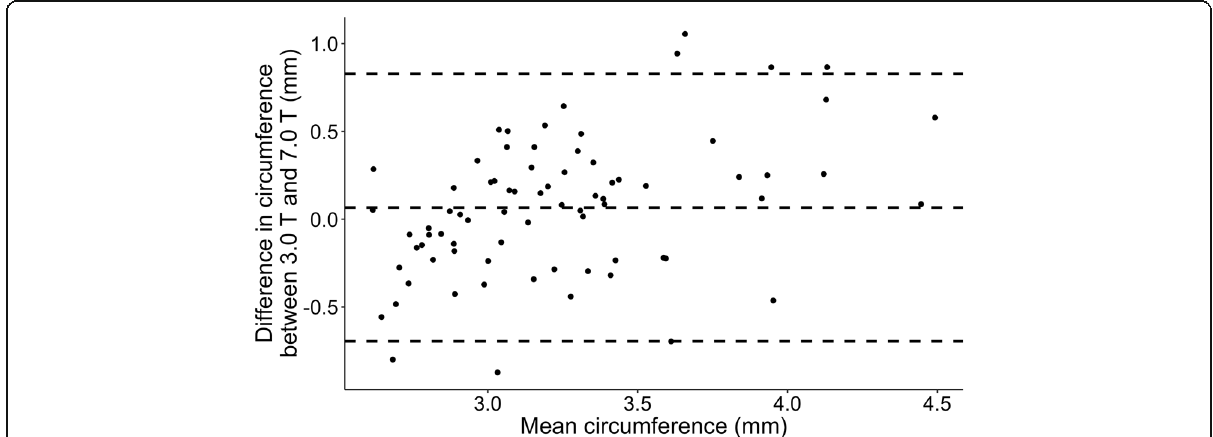
Fig. 3 Bland-Altmann plot depicting agreement between circumference measurements of intradural MMA 3.0 T vs 7.0 T within subject, within drug, within time point analyzed with LAVA software. Each point represents difference in circumference between 3.0 T and 7.0 T as a function of mean of the two measurements. Dashed lines are overall mean of differences